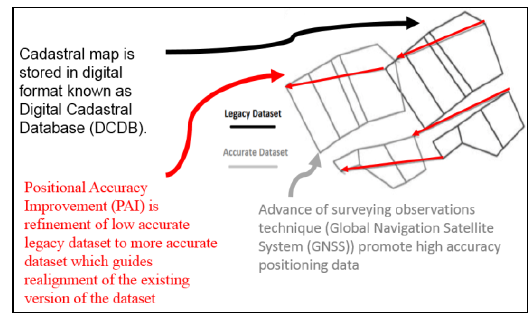
Figure 1. PAI concept (Hashim et al, 2016)